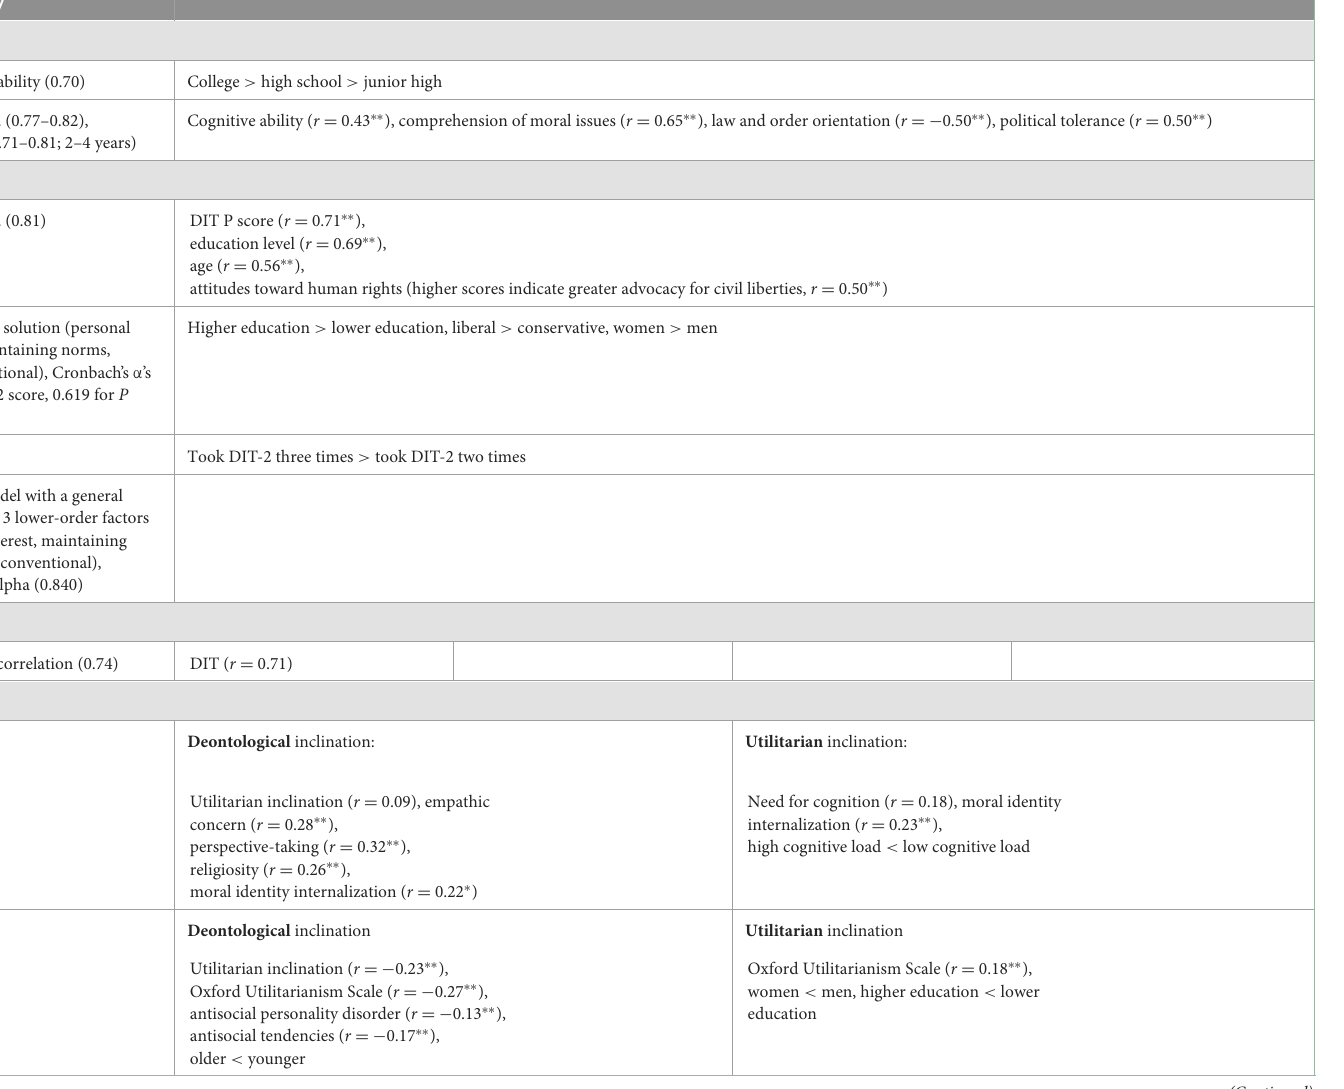
TABLE 4 Summary of factorial structure, reliability estimates, and relationships of the measure with other variables/group differences.